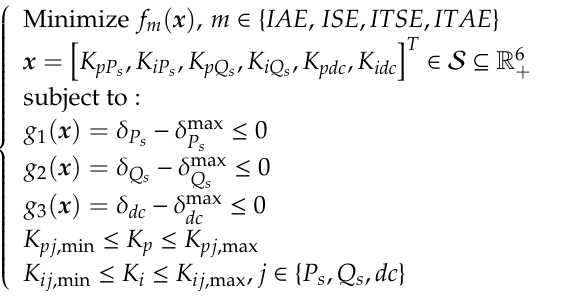
denotes the bounded search space for all PI parameters.